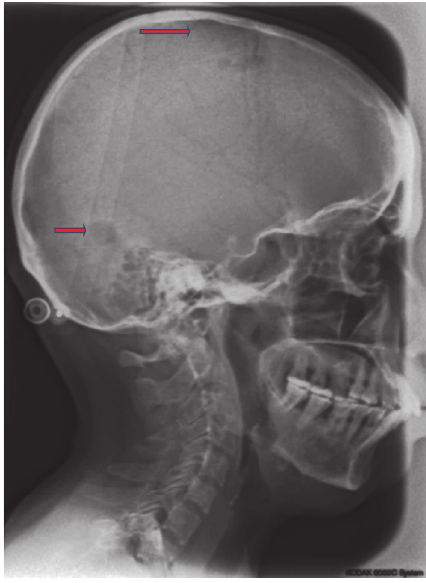
Figure 6: Skull radiograph showing osteolytic